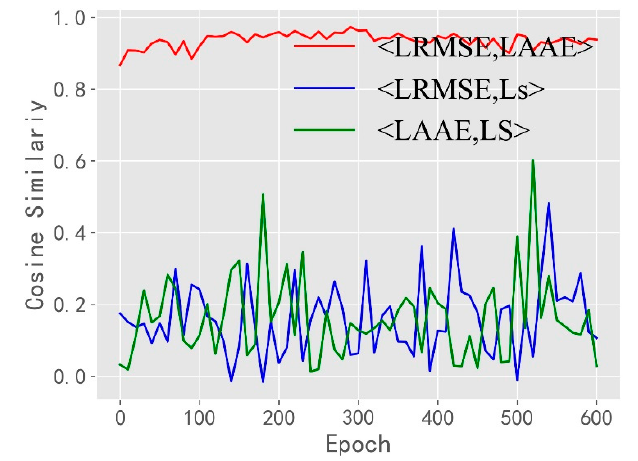
Figure 4. Cosine similarity between parts of the compound loss function.